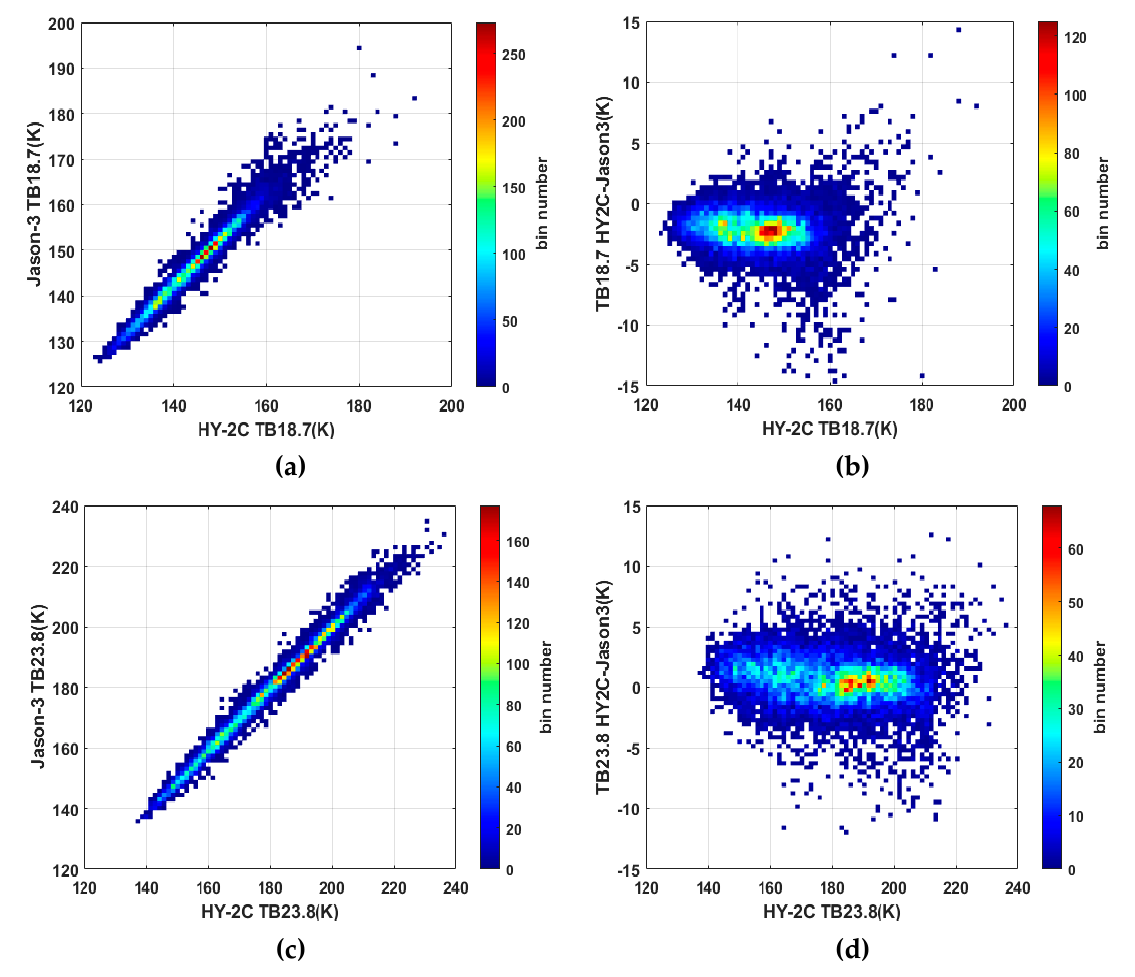
Figure 2. ( a ): HY-2C TB versus Jason-3 TB 18.7, in K; ( b ): HY-2C TB versus brightness temperature difference between HY-2C and Jason-3, in K; ( c ): HY-2C TB versus Jason-3 TB 23.8, in K; ( d ): HY-2C TB versus brightness temperature difference between HY-2C and Jason-3, in K. Using crossover points between HY-2C CMR and Jason-3 AMR-2, we have calculated the mean deviation (HY-2C minus Jason-3), the standard deviation (STD), the correlation coefficient and the linear fitting coefficient between HY-2C brightness temperature and the corresponding ones of Jason-2. They are summarized in Table 1. Table 1. Statistical characteristics for the comparison between TBs from HY-2C and Jason-3. Channel